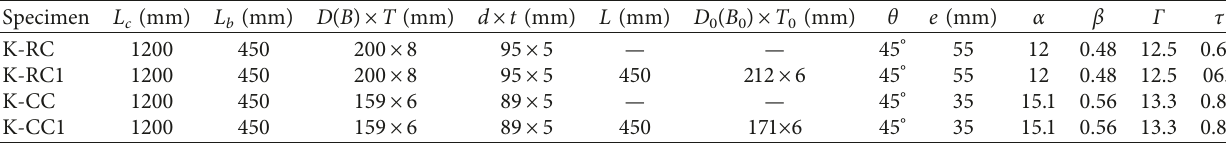
Figure 1: Design of the overlapped K-joints. (a) K-RC or K-CC. (b) K-RC1or K-CC1. Table 1: Geometrical parameters of the overlapped K-joints.